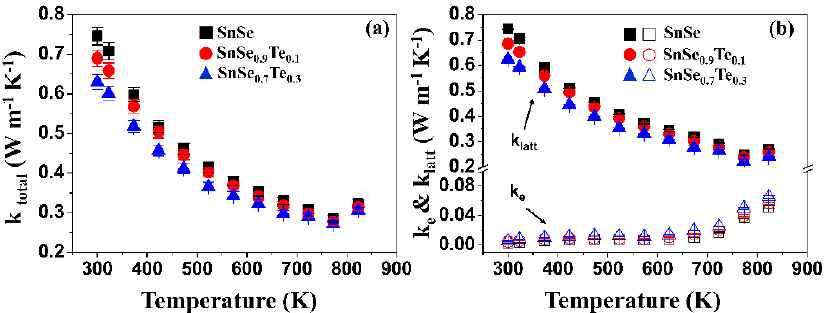
Figure 9. The temperature-dependency of ( a ) total thermal conductivity (k tot ), ( b ) electronic thermal conductivity (k e ), and the lattice thermal conductivity (k latt ) of the polycrystalline SnSe 1 − x Te x . (hollow shapes - k e , filled shapes - k latt ).